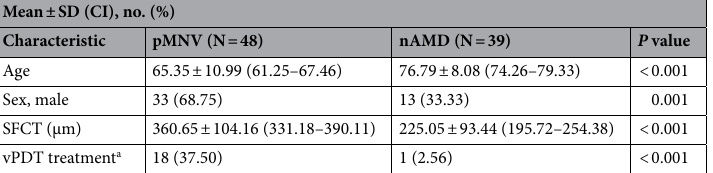
Table 1. Demographics of the study population at the time of the first diagnosis. CI = Confidence Intervals; IVT = Intravitreal injection; MNV = Macular neovascularization; nAMD = Neovascular age-related macular degeneration; SD = Standard Deviation; SFCT = Subfoveal choroidal thickness; vPDT = Verteporfin Photodynamic therapy; pMNV = Pachychoroid disease complicated by MNV. a Number of patients undergone vPDT after the first diagnosis of MNV.